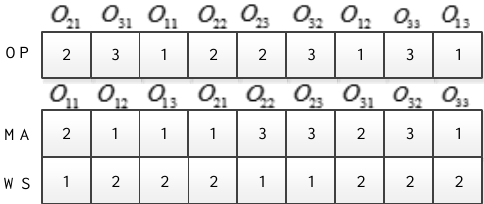
Figure 1. A scheduling scheme for a 3 × 3 × 2 energy-aware dual-resource constrained flexible job shop scheduling problem (EDRCFJSP) with three jobs, three machines and two